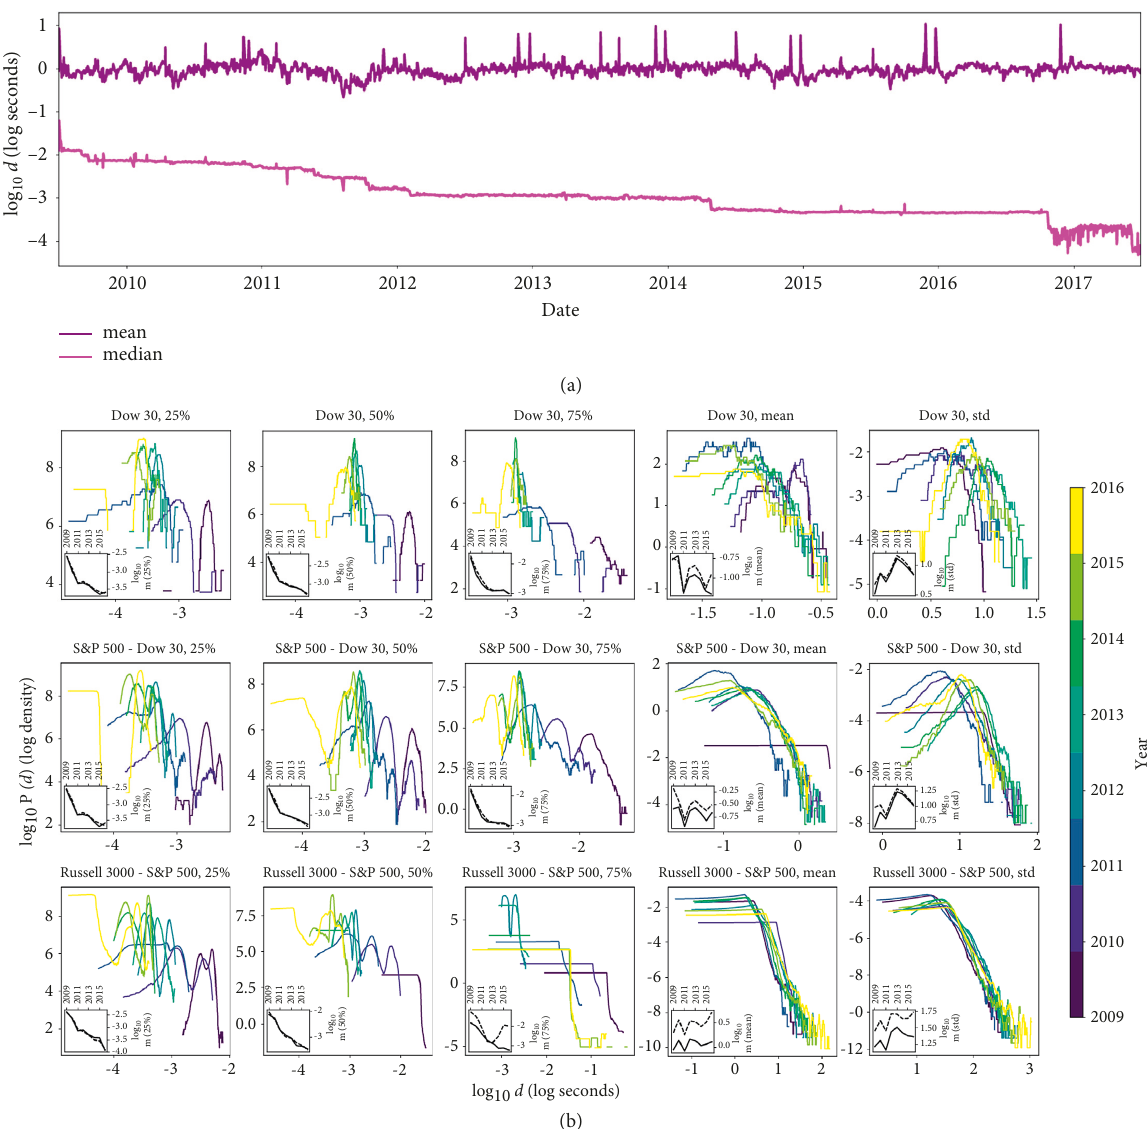
Figure 7: (a) Longitudinal dynamics in the mean and median dislocation duration. While the mean dislocation duration has remained relatively constant, the median has gradually decreased. The lower grid shows distributions of quantile and moment-based statistics over dislocation durations, for each calendar year and multiple disjoint sets of trading symbols. Distributions of quantile-based statistics (25th, 50th, and 75th percentiles) of dislocation duration declined by an order of magnitude over the study period, universally across the different sets of trading symbols, as displayed in the insets in (b). These two observations indicate that the “typical” dislocation duration has decreased, while the incidence of rare, long duration dislocations has increased. Table 1: Linear regression diagnostics for the VIX as a function of trade statistics, dislocation statistics, and venue fluctuation. Dep. variable VIX R